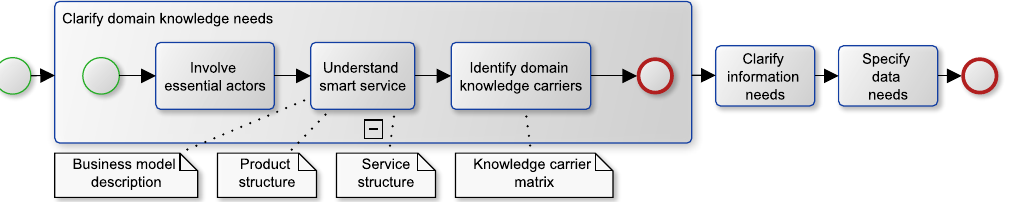
Figure 5. Process steps to clarify domain knowledge